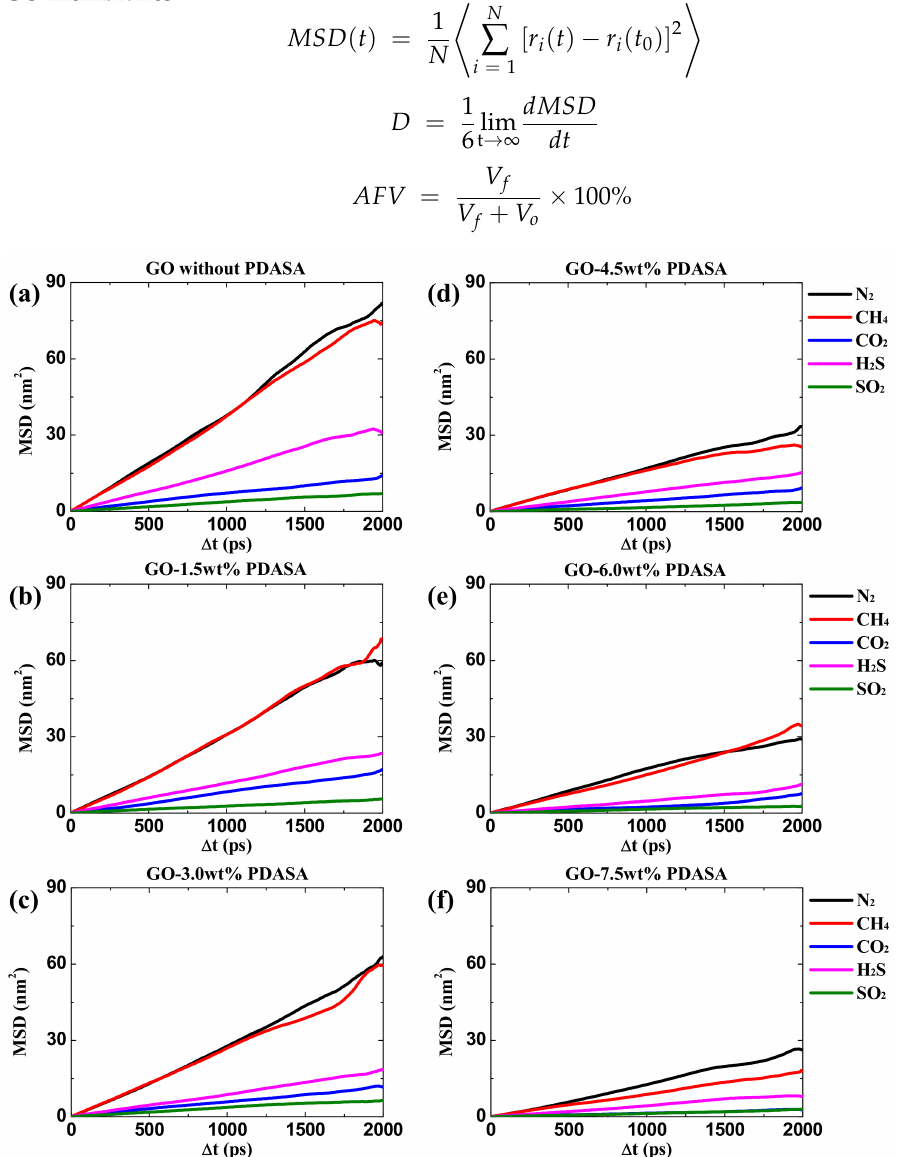
Figure 5. Mobility of gases in GO channels with variable doping amount of PDASA. ( a ) 0.0 wt%. ( b ) 1.5 wt%. ( c ) 3.0 wt%; ( d ) 4.5 wt%; ( e ) 6.0 wt%; ( f ) 7.5